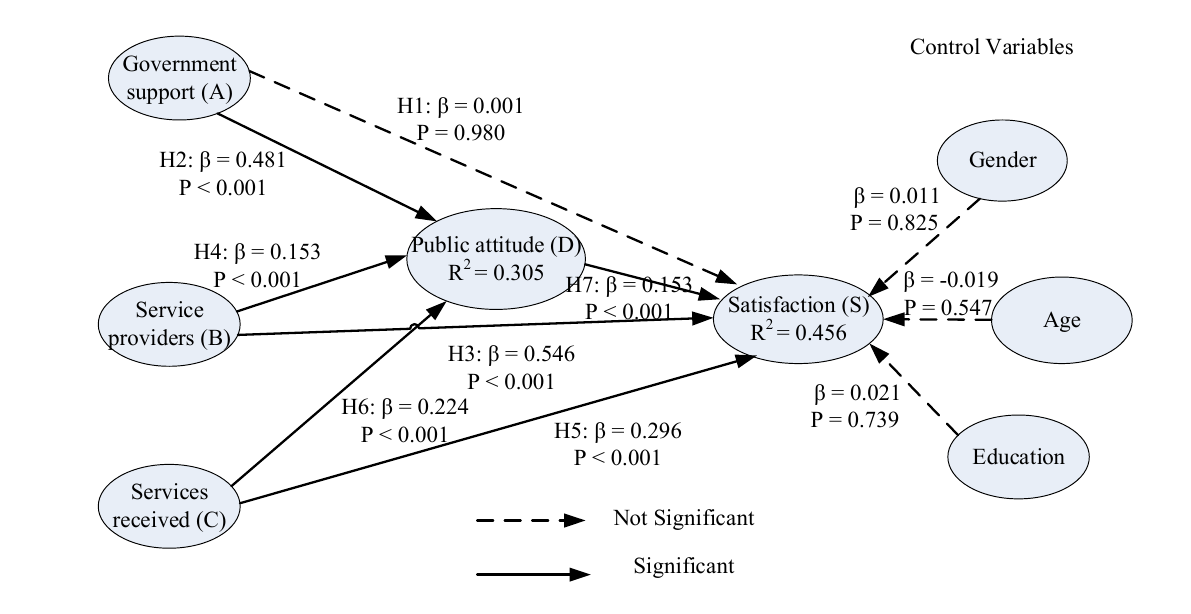
Figure 3. Results for the structural model. Table 10. Estimates of the structural